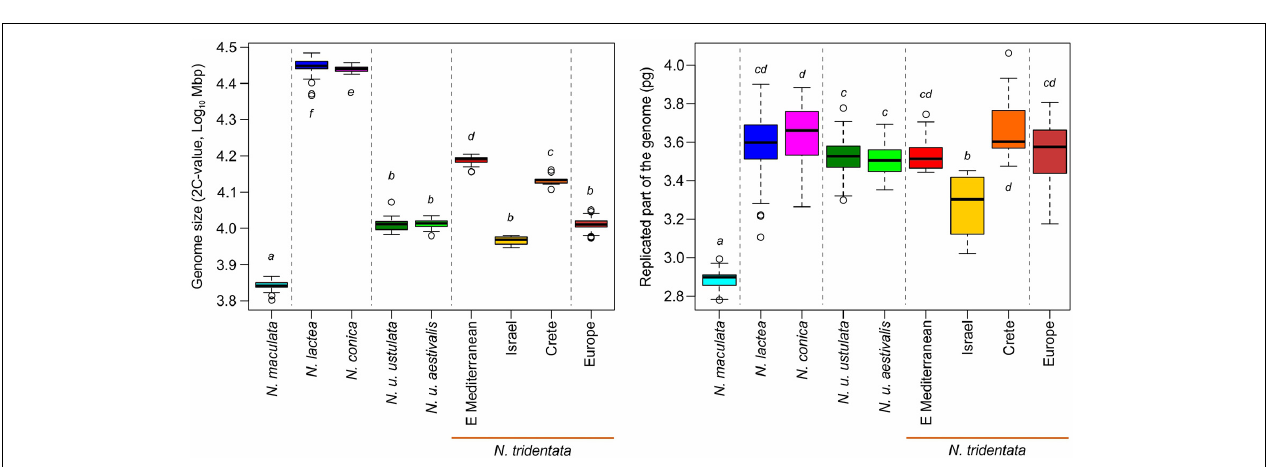
FIGURE 4 | Scatter-plot of the genome size and endoreplication pattern expressed as genome size of the endoreplicated part of the genome (P) . Whereas all diploid taxa exhibit similar values of P (less than 4 pg regardless of their overall genome size), polyploids are characterized by values of P increased by the same fold as their ploidy level.